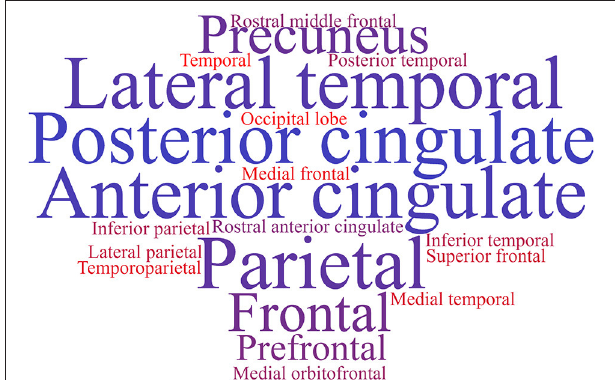
FIGURE 1 | Tag cloud of the most used brain regions in amyloid studies based on the information retrieved from seven papers (Chételat et al., 2011; Ewers et al., 2012; Oh et al., 2014; Besson et al., 2015; Mattsson et al., 2015; Hanseeuw et al., 2017; Halawa et al.,